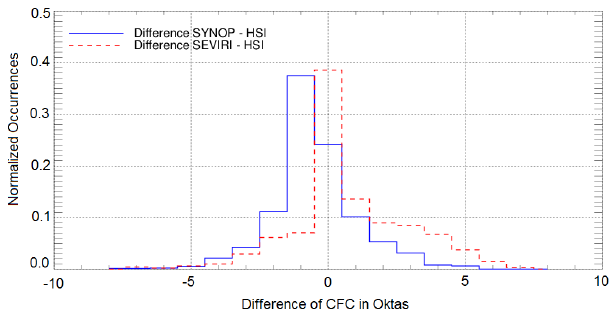
Figure 7. Histogram of instantaneous CFC differences (solid blue: SYNOP minus HSI at HAJ; dashed red: SEVIRI minus HSI at IMUK) from 1 July to 30 September 2009. Occurrences are nor- malized with their total count. Negative (positive) differences in- dicate that SEVIRI or SYNOP underestimate (overestimate) CFC compared to